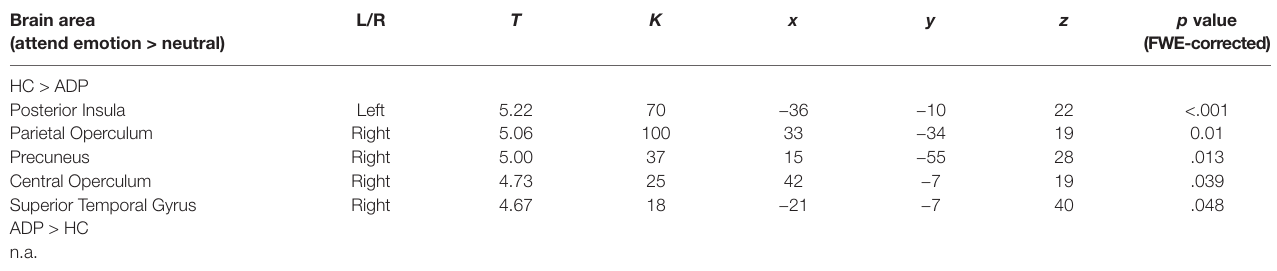
TABLE 2 | Main effect of participant group for attending emotional vs. neutral images. T , t value; K , cluster size in voxels; x , y , z are coordinates. Brain area (attend emotion >